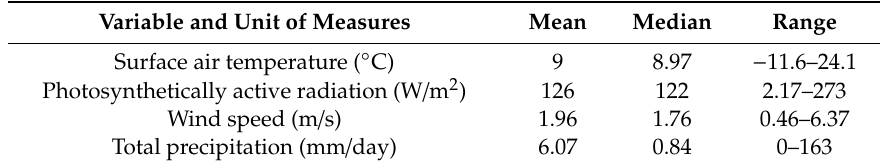
Table 2. List of meteorological variables extracted from the grid cell of the ERA-Interim reanalysis where Lake Varese is located. The mean, median, and range (minimum and maximum value) calculated over the period 2004–2014 are reported for each